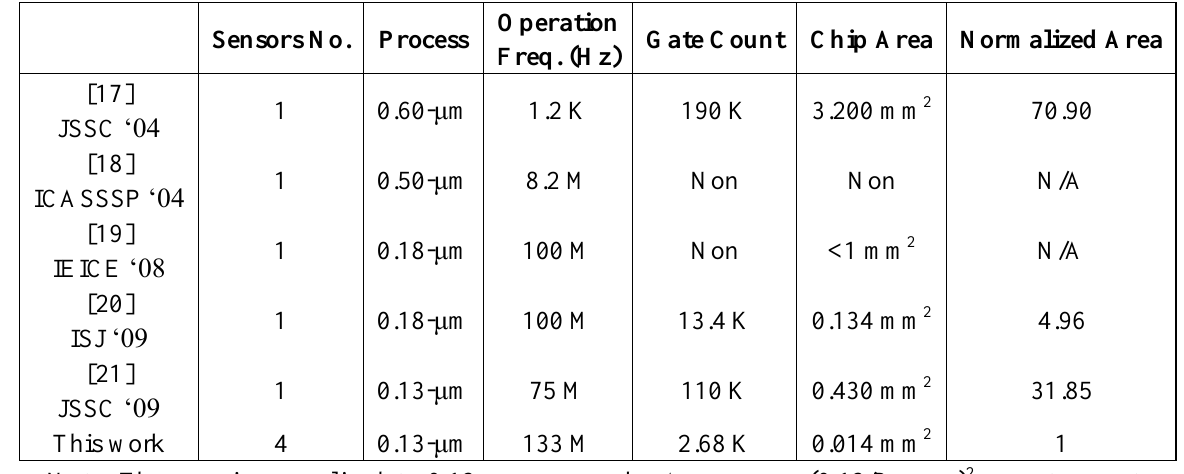
Table 3. MCU Comparison with Proposed